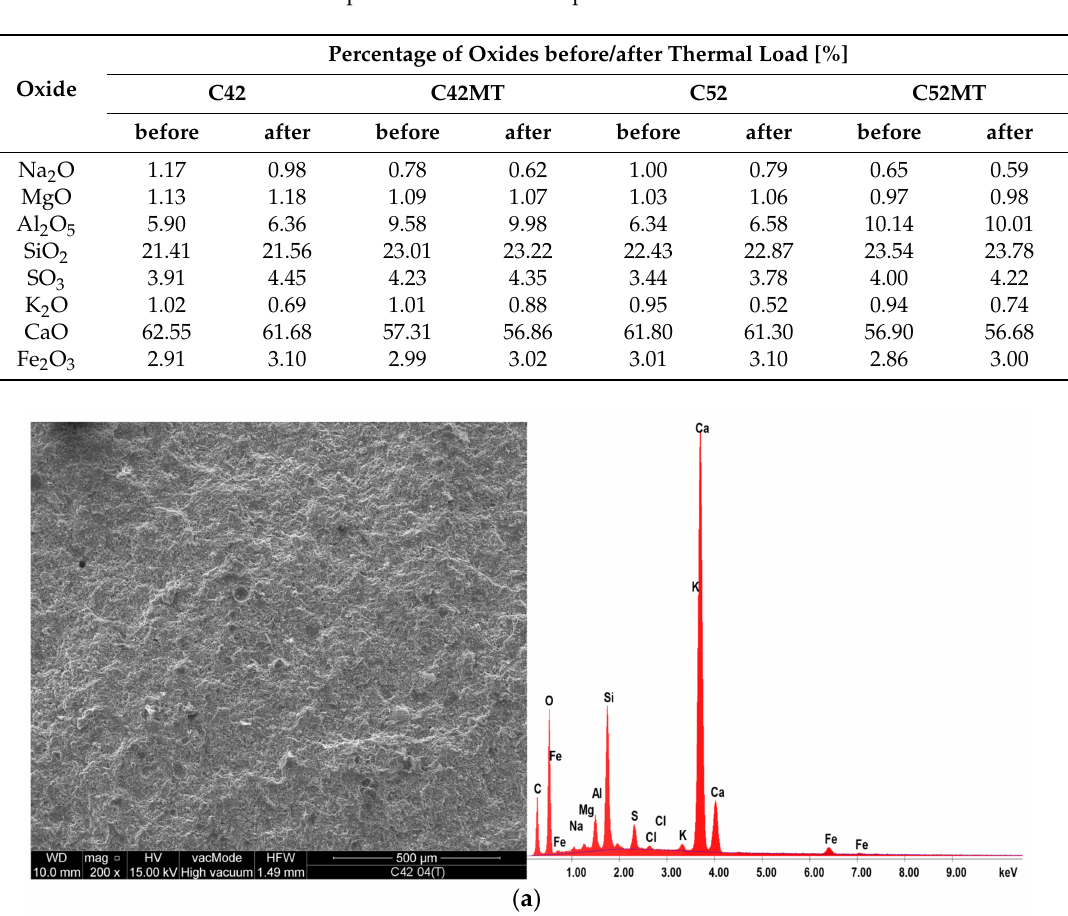
Table 3. The oxidized composition of the cement pastes before and after the thermal load.